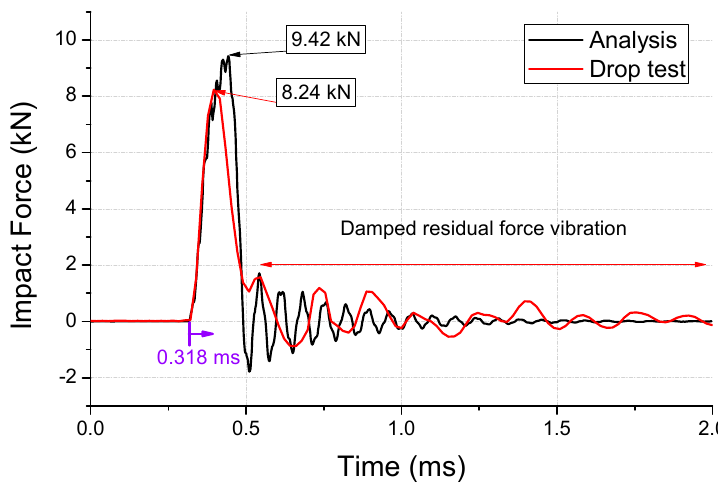
Figure 7. Damped impact force of the first-step drop-test and analysis.